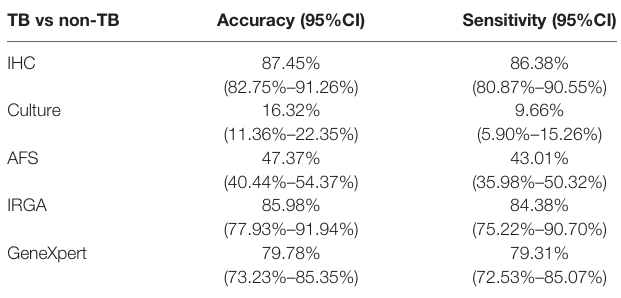
TABLE 1 | Diagnostic performance of ManLAM aptamer based- immunohistochemistry (IHC) and other methods for tuberculosis (TB) diagnosis.